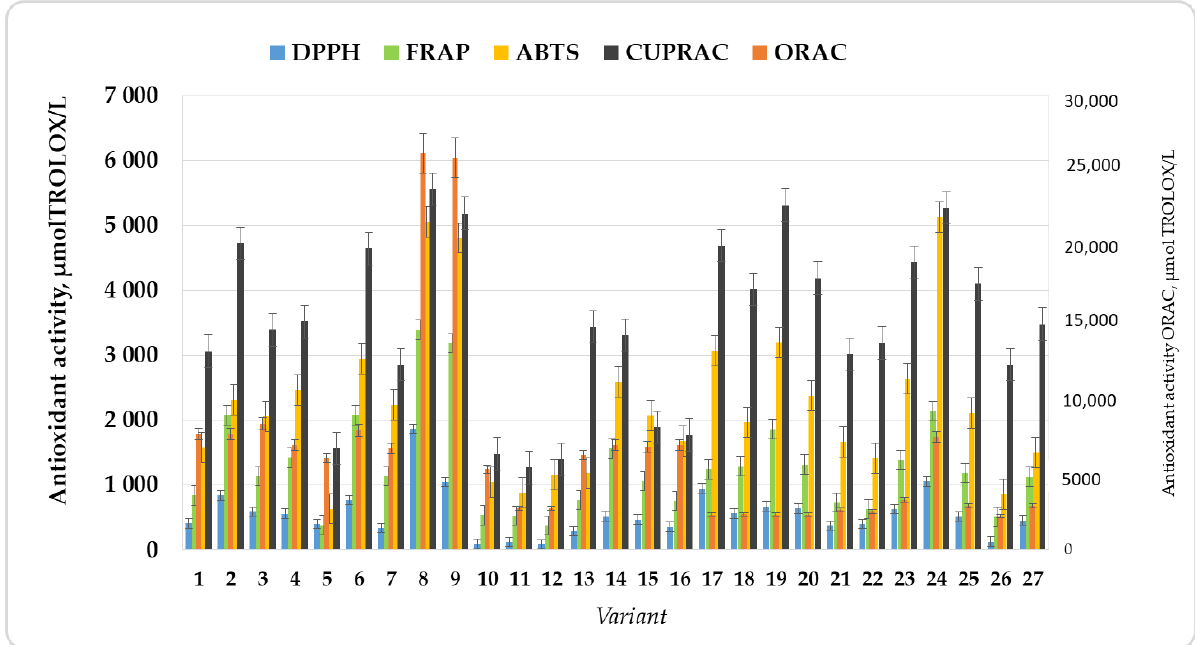
Figure 2. Antioxidant activity of different malt mixtures according to Table 1.